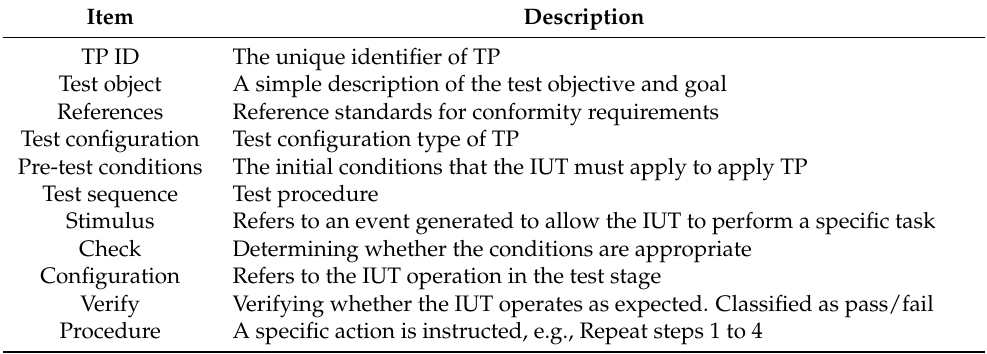
Table 4. Description of each item in